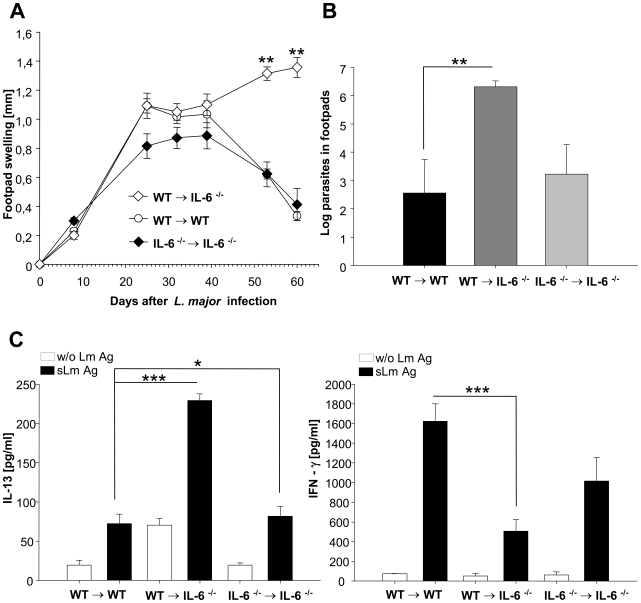
Experimental leishmaniasis in wt→IL-6 −/− chimeric mice.
A) Footpad swelling (compared to the not infected contra lateral footpad) (mm) of infected wt→IL-6 −/− chimeric mice, control wt→wt mice and control IL-6 −/− →IL-6 −/− chimeric mice ** = p<0.01, Student's t-test. B) Limiting dilution assay (LDA) from footpads of wt→IL-6 −/− chimeric mice, control wt→wt mice and control IL-6 −/− →IL-6 −/− chimeric mice 9 weeks after infection (mean */− SE of log parasites) ** = p<0.01, Student's t-test. C) IFNγ and IL-13 secretion of CD4+ cells isolated from draining lymph nodes of wt→IL-6 −/− chimeric mice, control wt→wt mice and control IL-6 −/− →IL-6 −/− chimeric mice 9 weeks after infection. Cells were incubated for 48 h with syngenic dendritic cells stimulated for 48h with soluble Leishmania antigen (s LmAg) (black bars) or with unstimulated syngenic dendritic cells (without (w/o) Lm Ag, open bars). Cytokines in culture supernatants were assayed by cytometric bead assay (mean ± SE, n = 3) * = p<0.05, *** = p<0.001, Student's t-test.